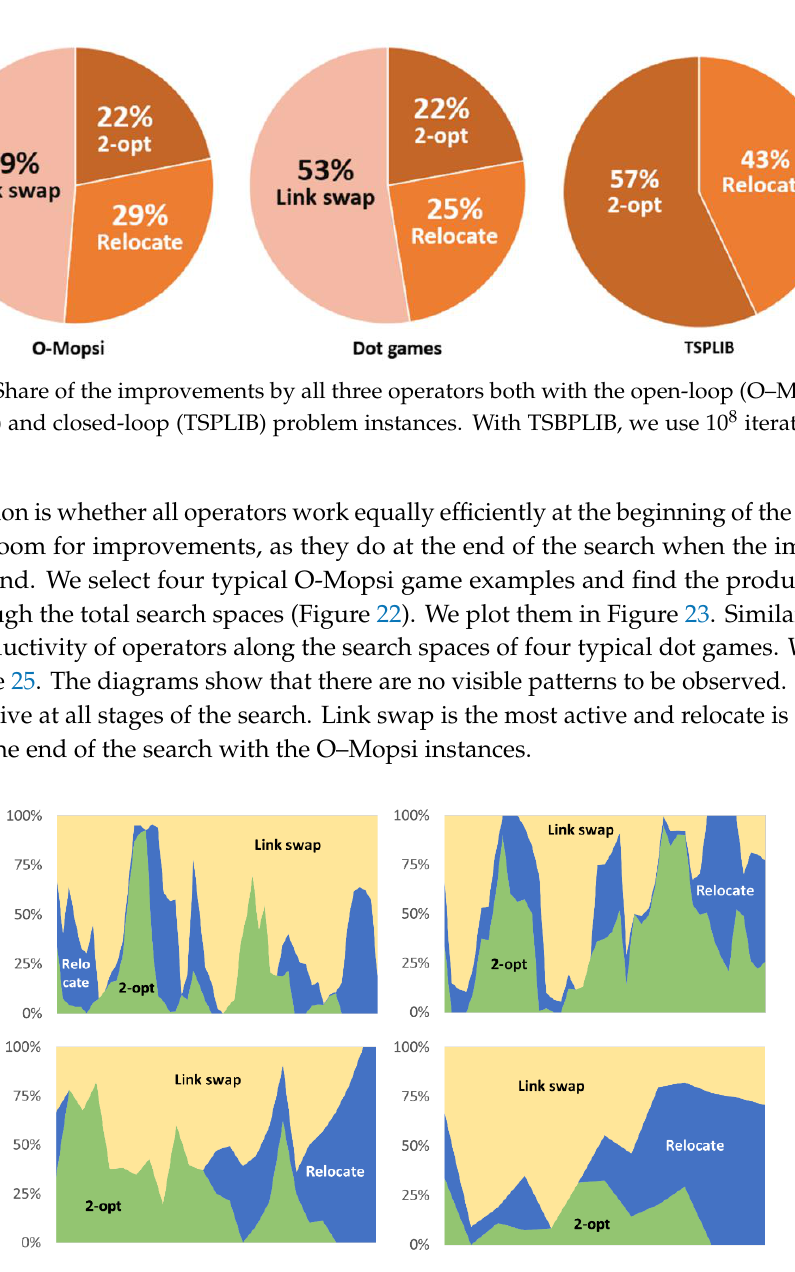
Figure 23. Screenshots of the 4 different O – Mopsi instances (in the same order).